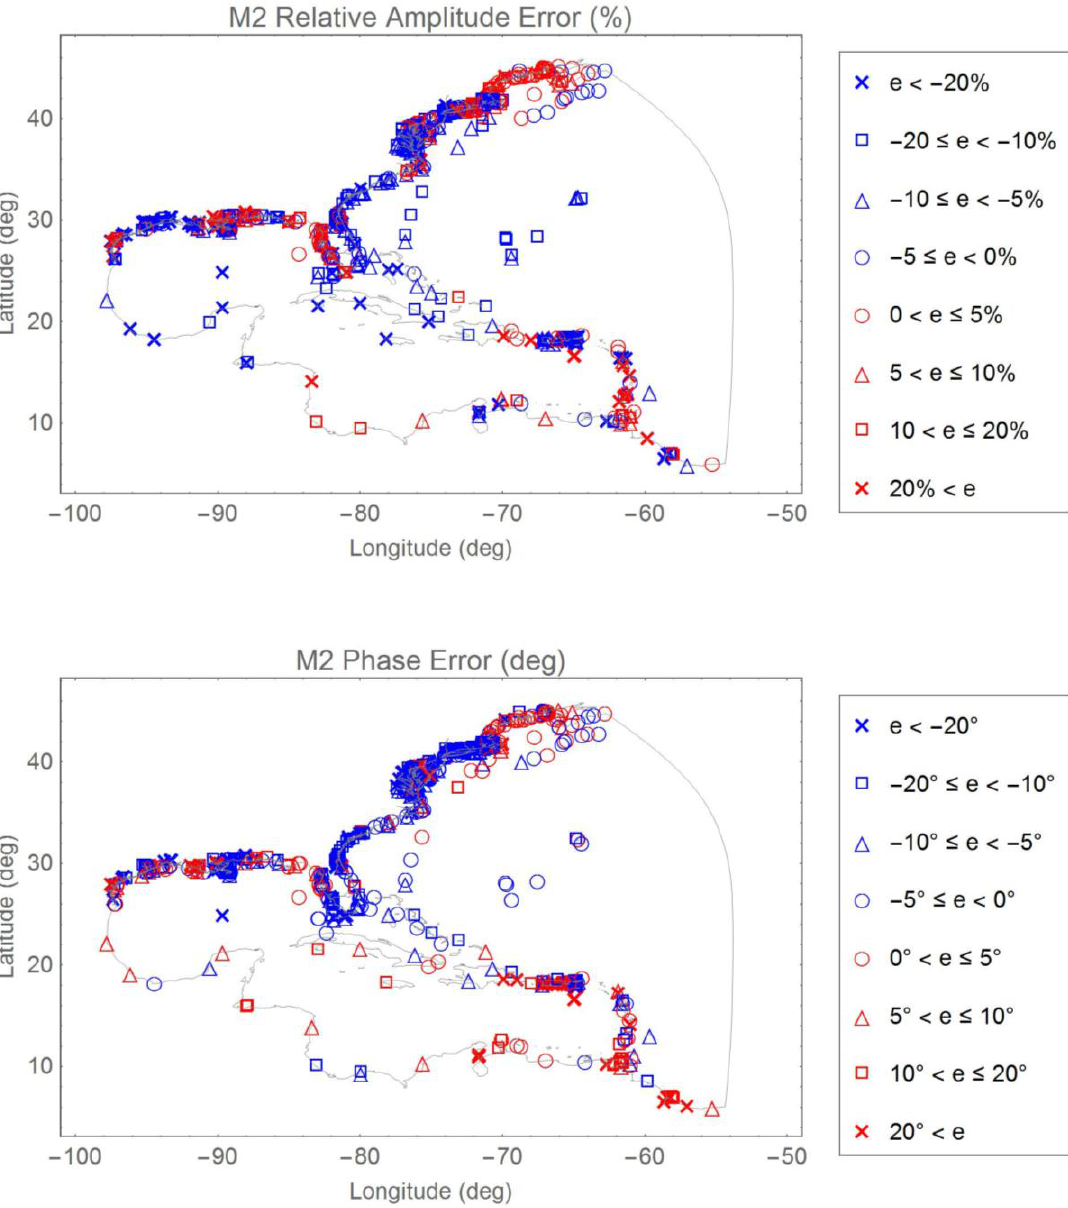
Figure C4. Distribution of relative amplitude and absolute phase errors for the M 2 constituent: global view.